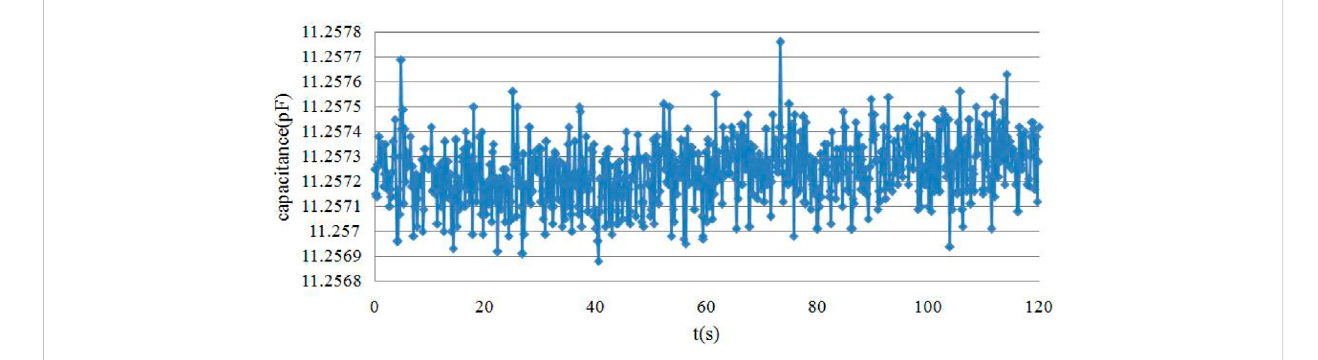
FIGURE 7 Measurement data of one adjacent electrode pair within 2 min.